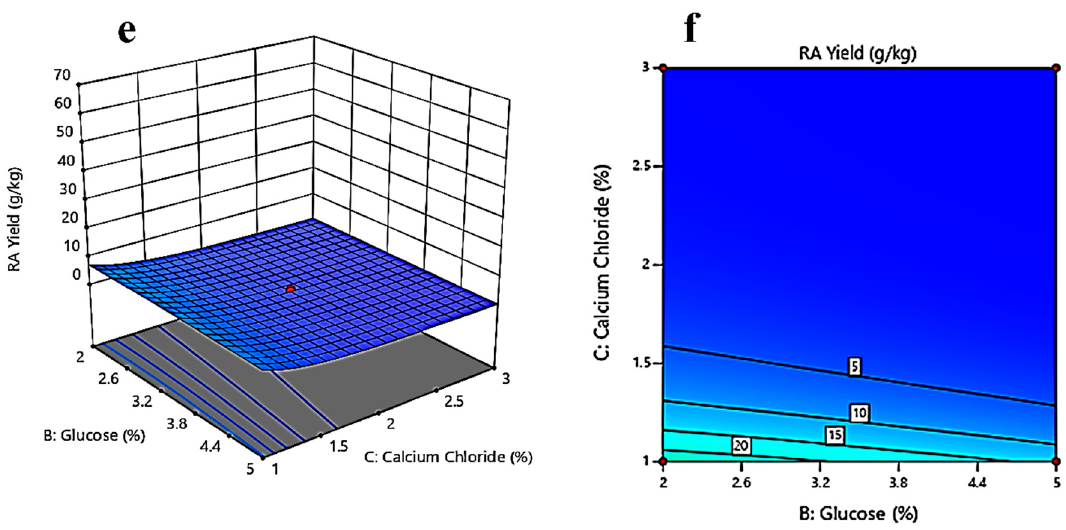
Figure 4. Three-dimensional surface optimization of ( a ) oil (%), and glucose (%); ( c ) oil (%), and calcium chloride (%); ( e ) glucose (%), and calcium chloride (%) on the ricinoleic acid yield (g/kg). Contour plots showing the effect of ( b ) oil (%), and glucose (%); ( d ) oil (%), and calcium chloride (%); ( f ) glucose (%), and calcium chloride (%) on the ricinoleic acid yield (g/kg).